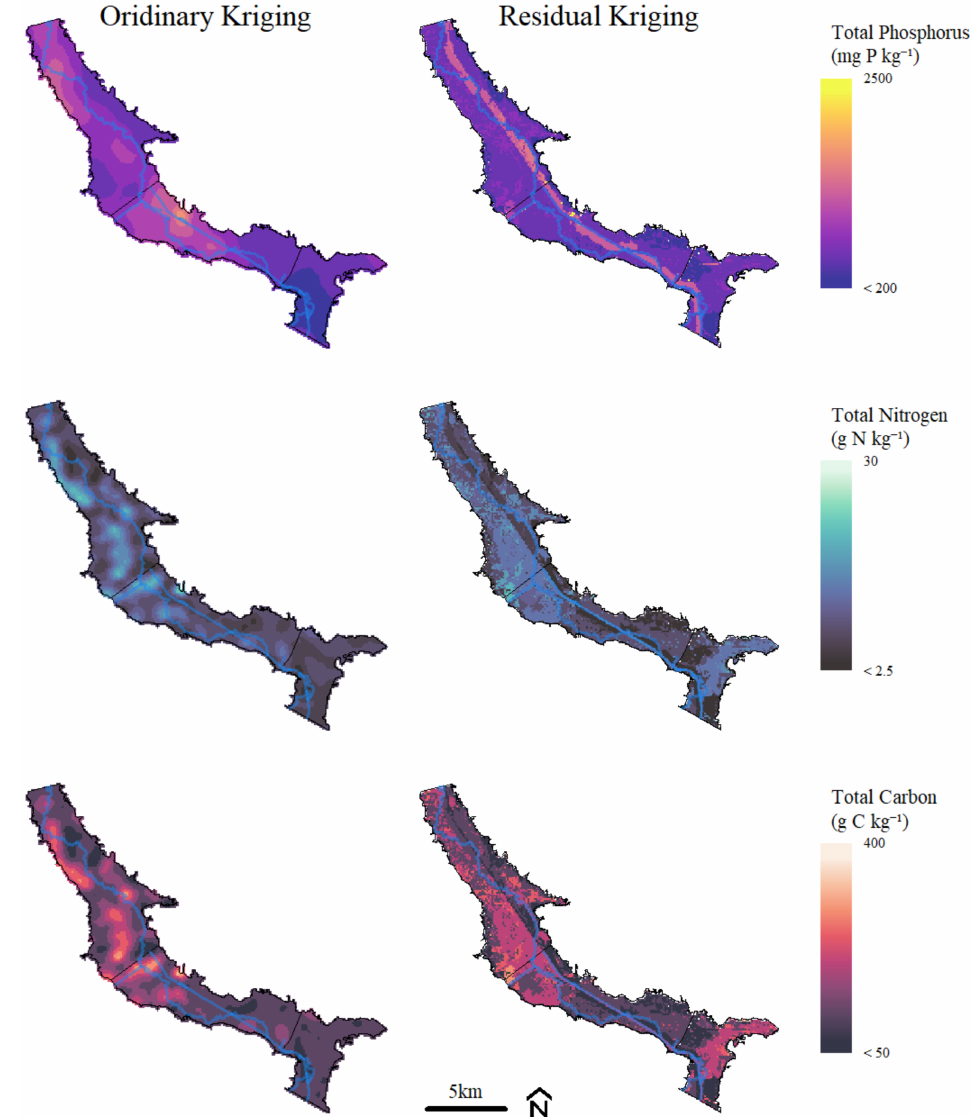
Figure 7. Spatial interpolation of soil properties using ordinary ( left ) and residual ( right ) kriging results for total phosphorus (TP, top ), total nitrogen (TN, middle ), and total carbon (TC, bottom ) within the Kissimmee River